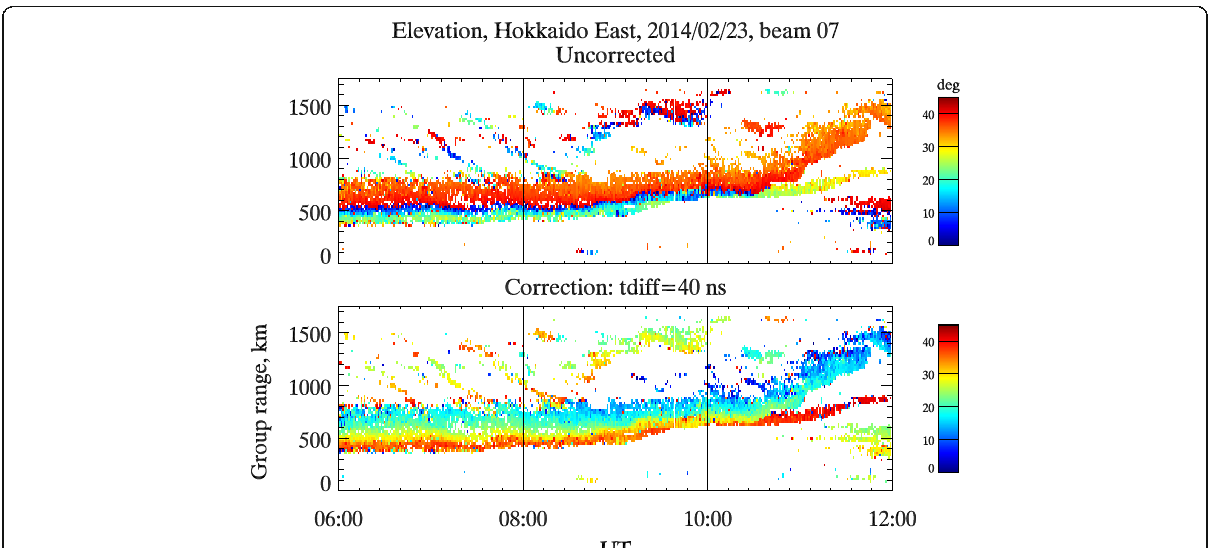
Fig. 25 Range-Time-Parameter plots of elevation angle for beam 7 of the HOK data at 06 – 12 UT on 23 February 2014 for: uncalibrated (top) and calibrated data (bottom). Adapted from Fig. 6 of Ponomarenko et al.